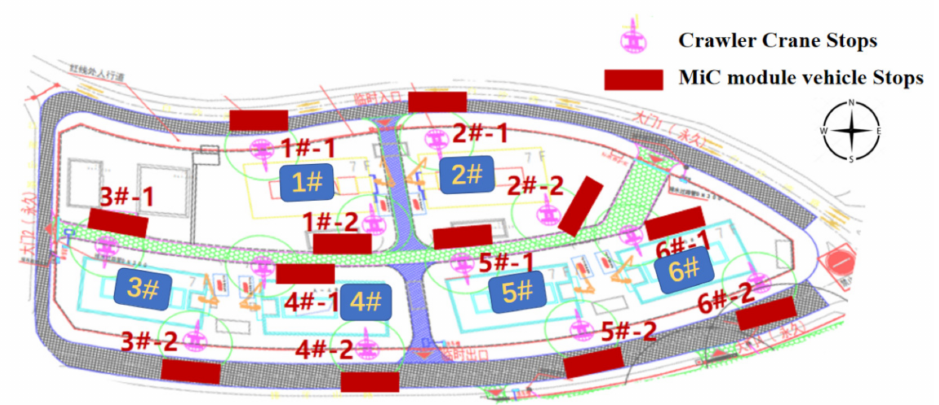
Figure 9. Layout diagram of crawler crane and MiC module vehicle parking